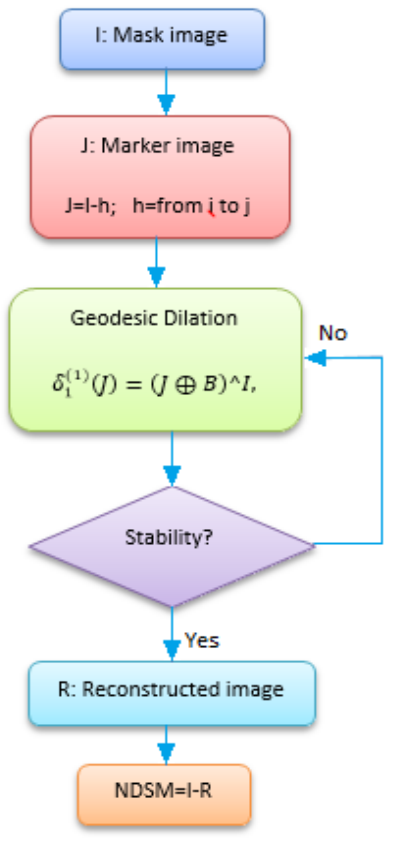
Figure 1. Steps of segmentation (H. Arefi, M. Hahn,